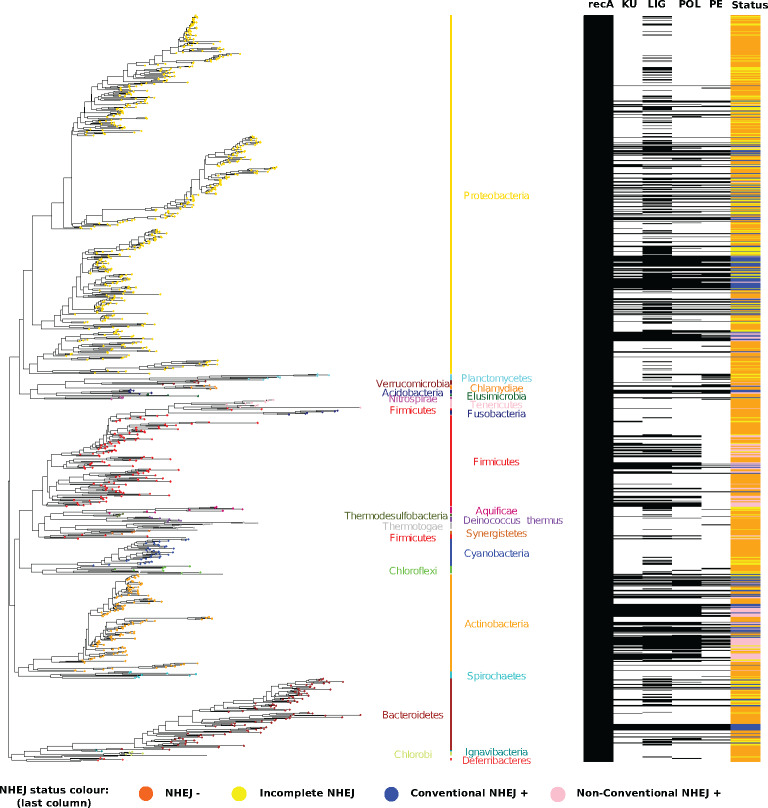
NHEJ is sporadically distributed across bacteria. 16S rRNA-based species phylogenetic tree of 969 bacterial species (left) with presence/absence matrix of RecA, KU, LIG, POL, and PE domains (right). These species were included such that each genus was chosen once for each NHEJ state (see Phylogenetic Tree Reconstruction section for further details). Tip labels, representing bacteria, are colored according to the phylum names and bars (right of the phylogenetic tree) that the given tip belongs to. The phylum names arranged on either sides of the vertical bars are for representational purposes only. The first five columns of the presence/absence matrix (extreme right of the figure) depict the status if the given protein (RecA) or domain (Ku, LIG, POL, and PE) is present (black horizontal bar) or absent (white horizontal bar) in the corresponding bacteria. Each horizontal bar maps to a bacterial tip on the phylogenetic tree (left). Horizontal bars in the last column of the matrix represent the overall NHEJ status for a given species (color legend same as in fig. 1). NHEJ status—orange: NHEJ−; yellow: incomplete NHEJ; blue: conventional NHEJ+; pink: nonconventional NHEJ+.